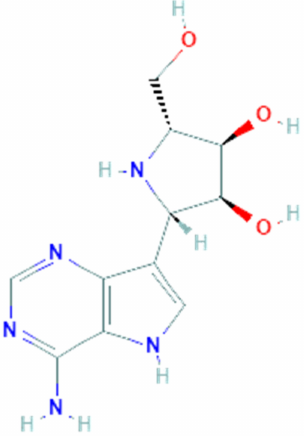
Figure 2. Chemical structure of